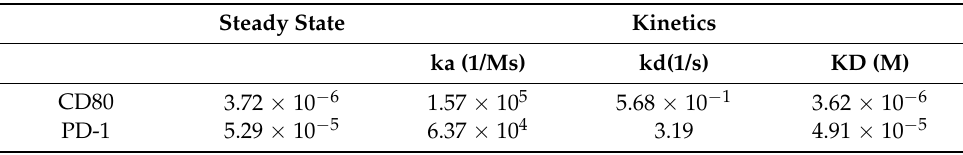
Table 1. CD80 and PD1 bind to HYBRI. Affinity constants (KD) were calculated from SPR analysis in the steady state and from the kinetics